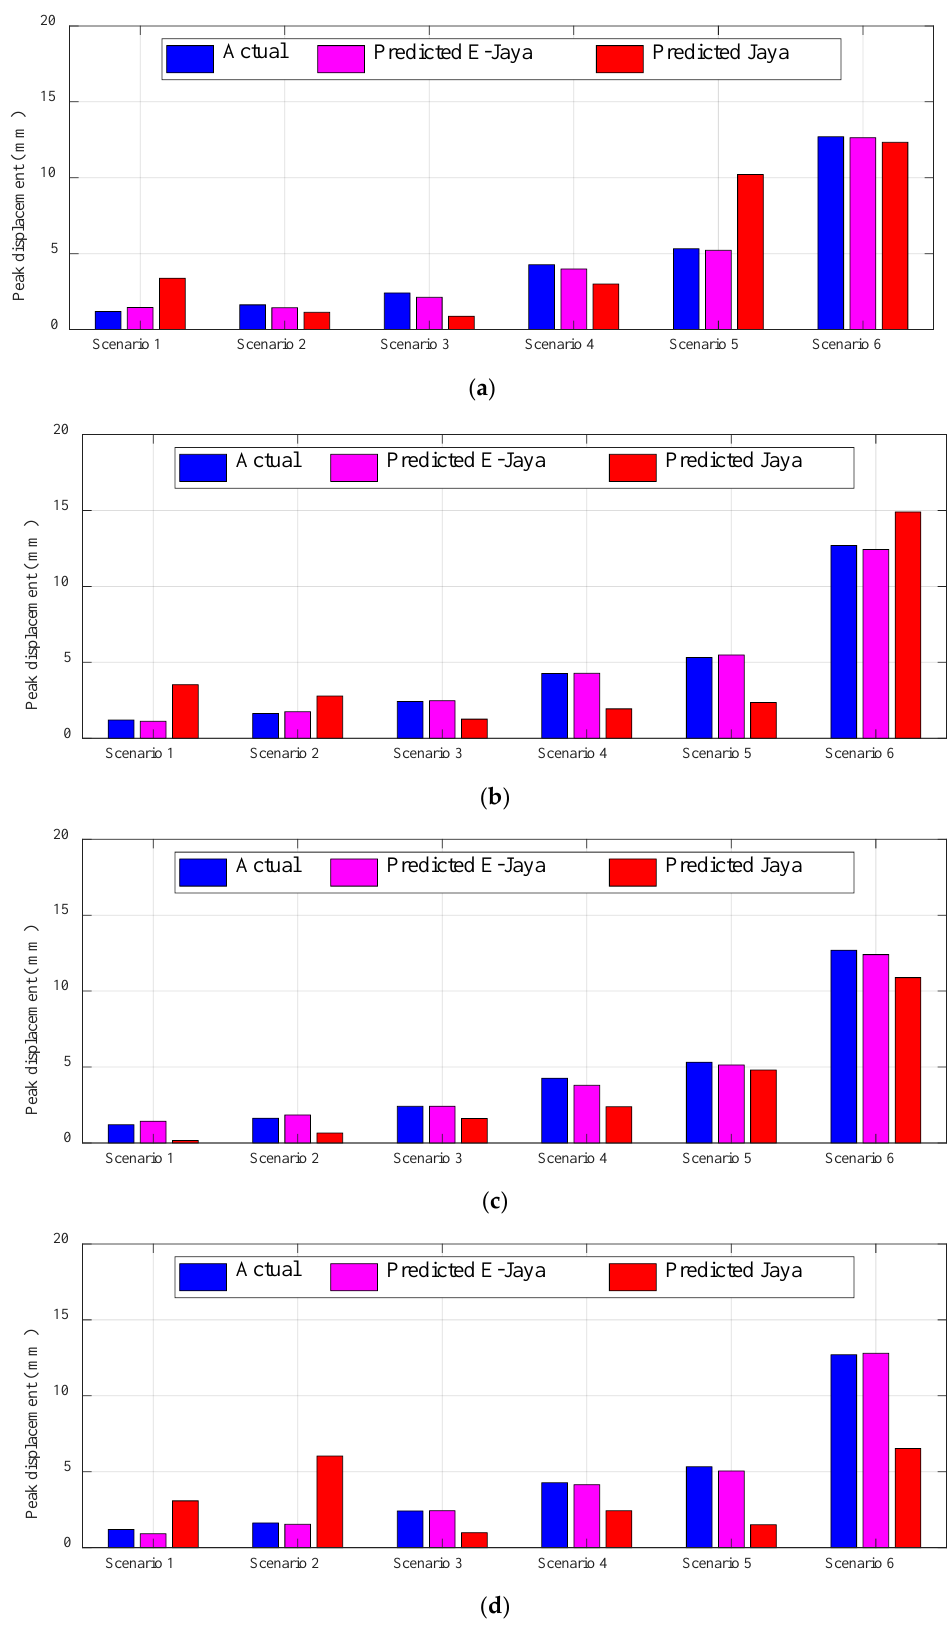
Figure 9. Peak displacement prediction for six scenarios: ( a ) H = 6, ( b ) H = 8, ( c ) H = 10, ( d ) H = 12. The present study aimed to evaluate the performance of an enhanced artificial neural network (ANN) model using E-Jaya with different hidden layer sizes for composite pipes. The correlation data obtained from this study showed that the enhanced ANN using E- Jaya with eight neurons outperformed the other networks for composite pipes.